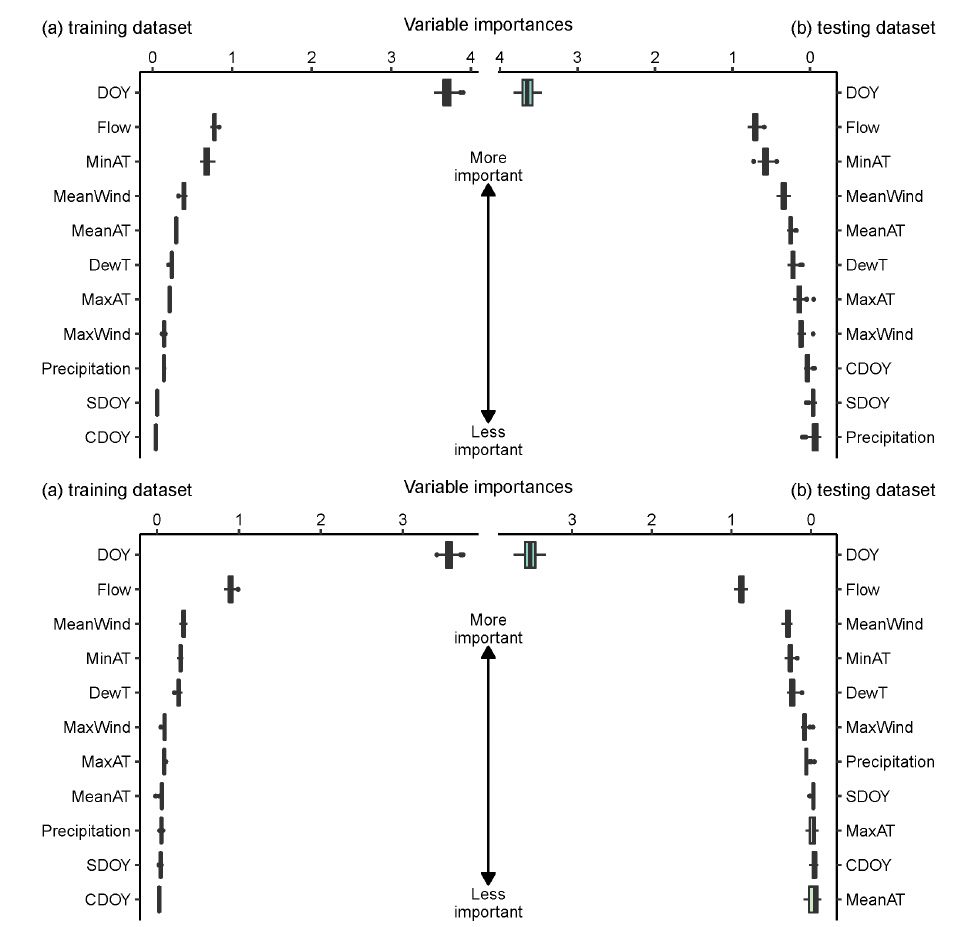
Figure 5. Permutation importance in GB and AB; GB, gradient boosting regression, AB, adaptive boosting regression. (GB on the top , AB on the bottom , WT: ◦